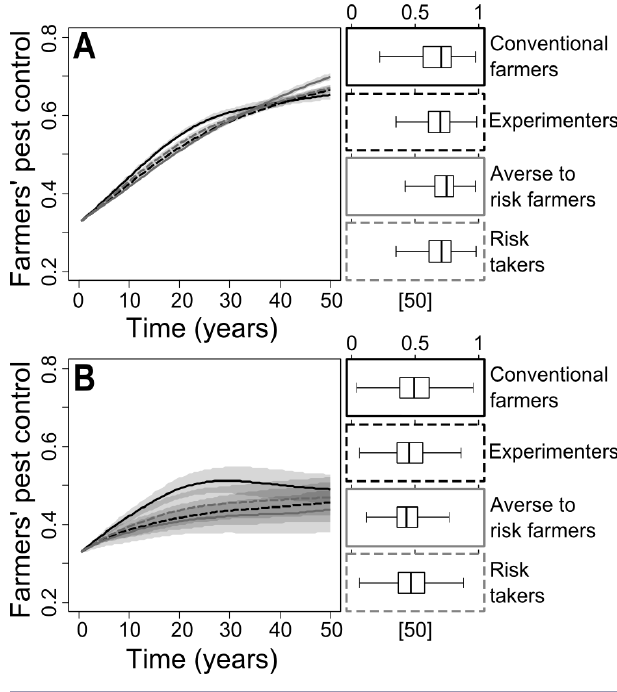
Fig. 3 . Adaptive management in pest control. Farmers’ pest control resulting from pest management practices is represented as a function of time without temperature variability (A), and with temperature variability (B). In the left graphs, the different curves represent communities of farmers dominated by conventional farmers (solid black lines), experimenters (dashed black lines), averse-to-risk farmers (solid grey lines), and risk takers (dashed grey lines). Areas shaded in grey represent standard deviations for each curve (30 simulations repetitions). The right graphs represent boxplots of the distribution of farmers’ pest control after 50 years.